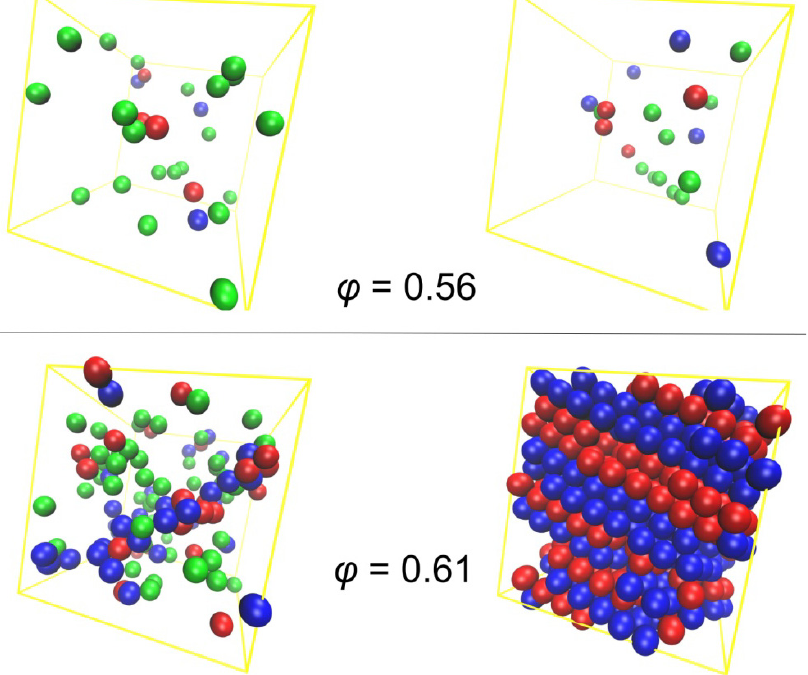
Figure 6. Same as in Figure 5, but following a different visualization pattern. Sites are color-coded according to the following scheme: Spheres with hexagonal close packing (hcp), face center cubic (fcc) and fivefold similarities are shown in blue, red and green colors, respectively; for visualization purposes all remaining spheres are omitted. Image created using the VMD software